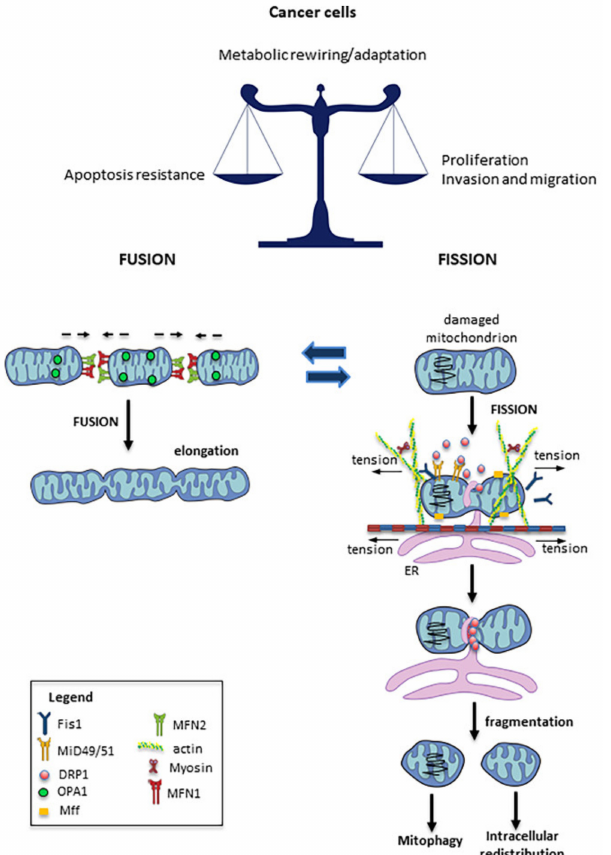
Figure 2. Mitochondrial fission and fusion: Mitochondrial fusion is mainly regulated by MFN1, MFN2, and OPA1 activity, which promote the fusion of juxtaposed mitochondrial membranes. The fusion process contributes to implementing respiration and mitochondrial metabolism, while limiting mitophagy and apoptosis. Mitochondrial fission is regulated by the GTPase activity of the DRP1 that is recruited to the mitochondria in response to stresses, and here interacts with its mitochondrial receptors (Mff1, Fis1, and MID49/51). DRP1 is responsible for mitochondrial fragmentation, as it physically constricts the mitochondrion by forming a ring structure located on the future mitochondrial fission